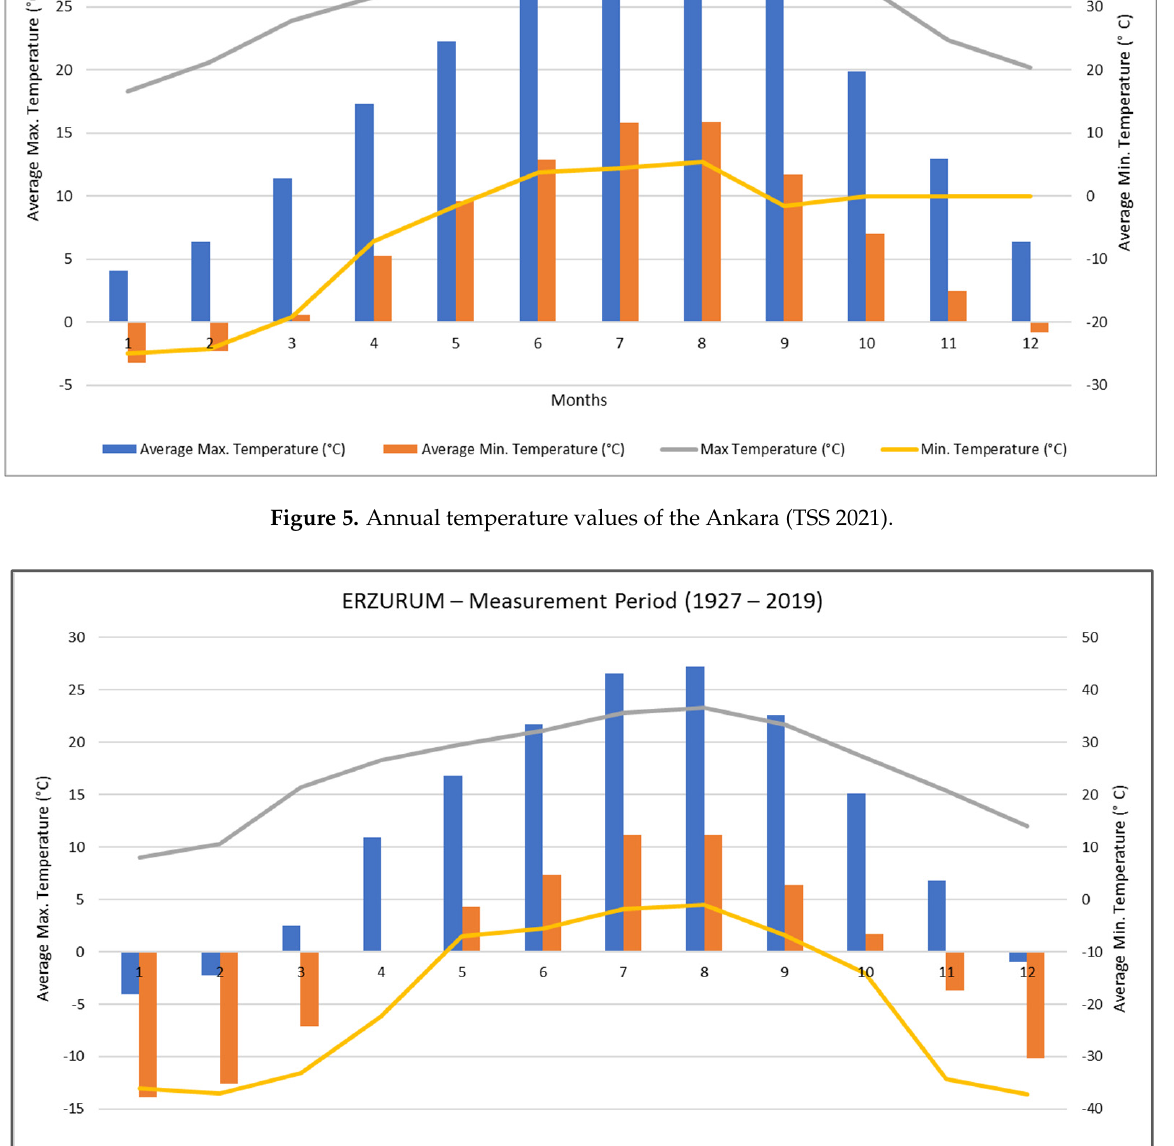
Figure 6. Annual temperature values of the Erzurum (TSS 2021).